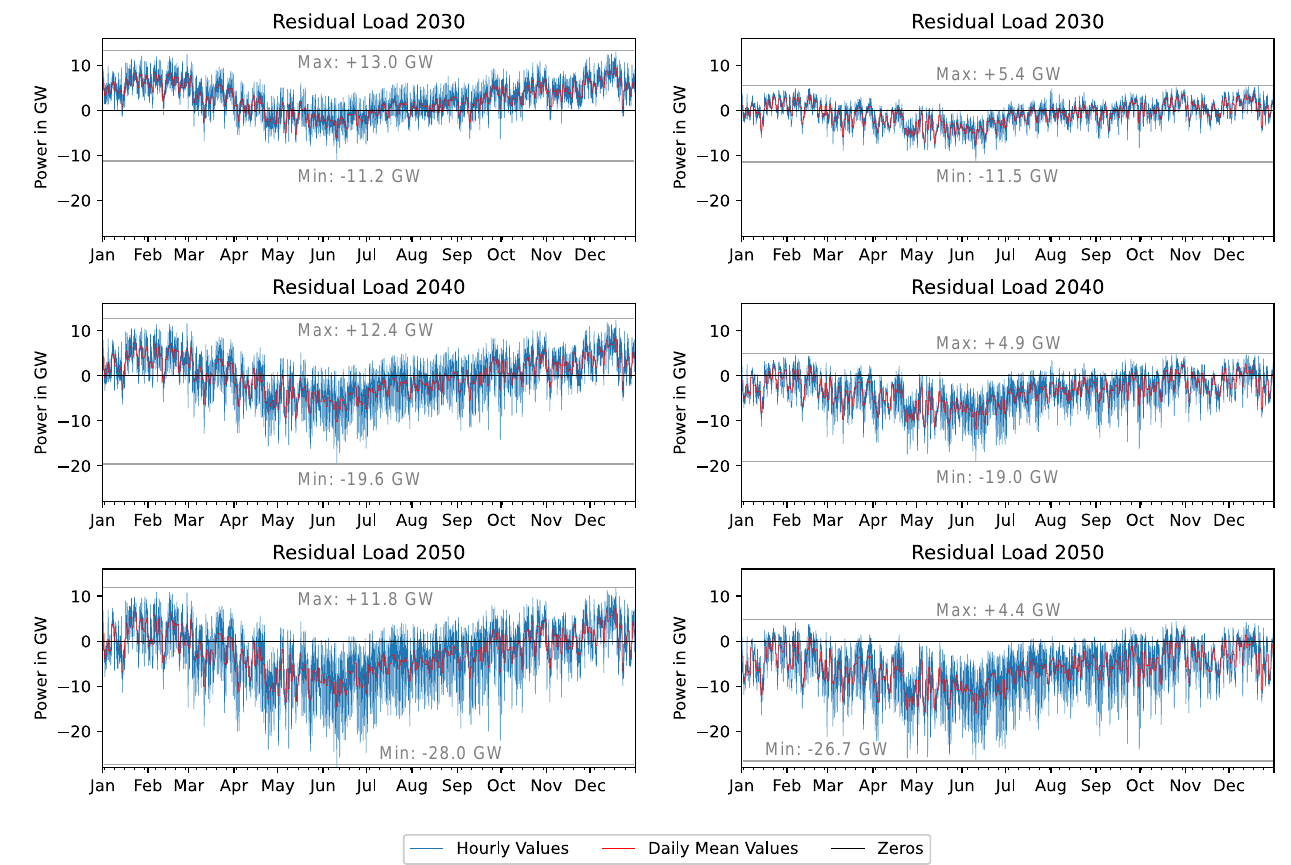
Figure 5. Residual load of both scenarios for all considered years.